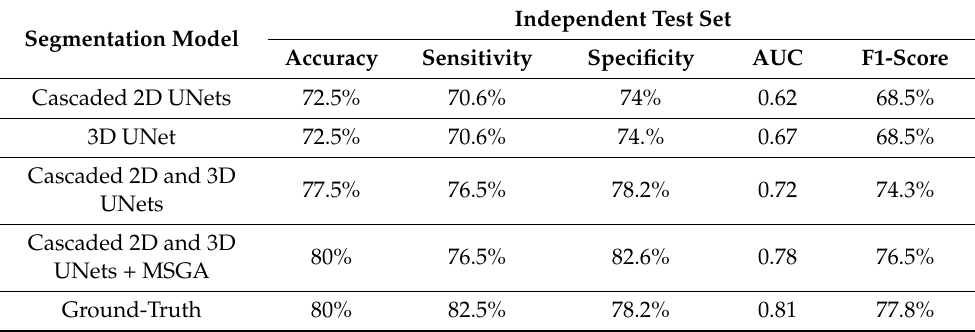
Table 3. Results of therapy outcome prediction using the radiomic models developed with different segmentation modules.